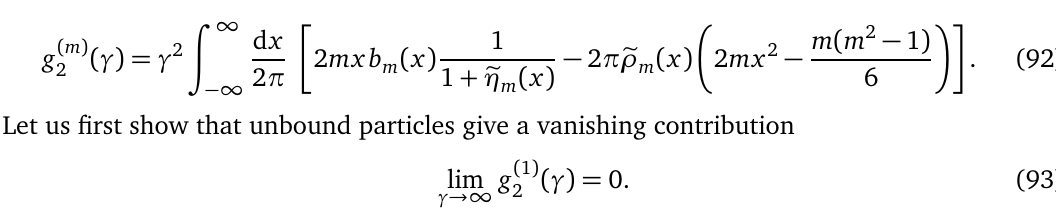
Figure 3: Density D bosons forming n -particle bound states as defined in (21). The plots correspond to ( a ) γ = 20, ( b ) γ = 2, ( c ) γ = 0.2. The total density is fixed D = 1. The energy densities e negative for n ≥ 2 (i.e. | e